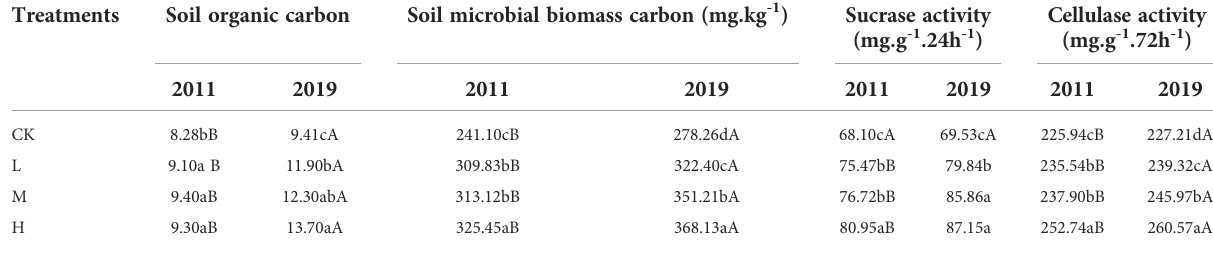
TABLE 2 Soil organic carbon, soil microbial biomass carbon, sucrase activity and cellulase activity at fi lling stage of winter wheat under different treatments in different years. Treatments Soil organic